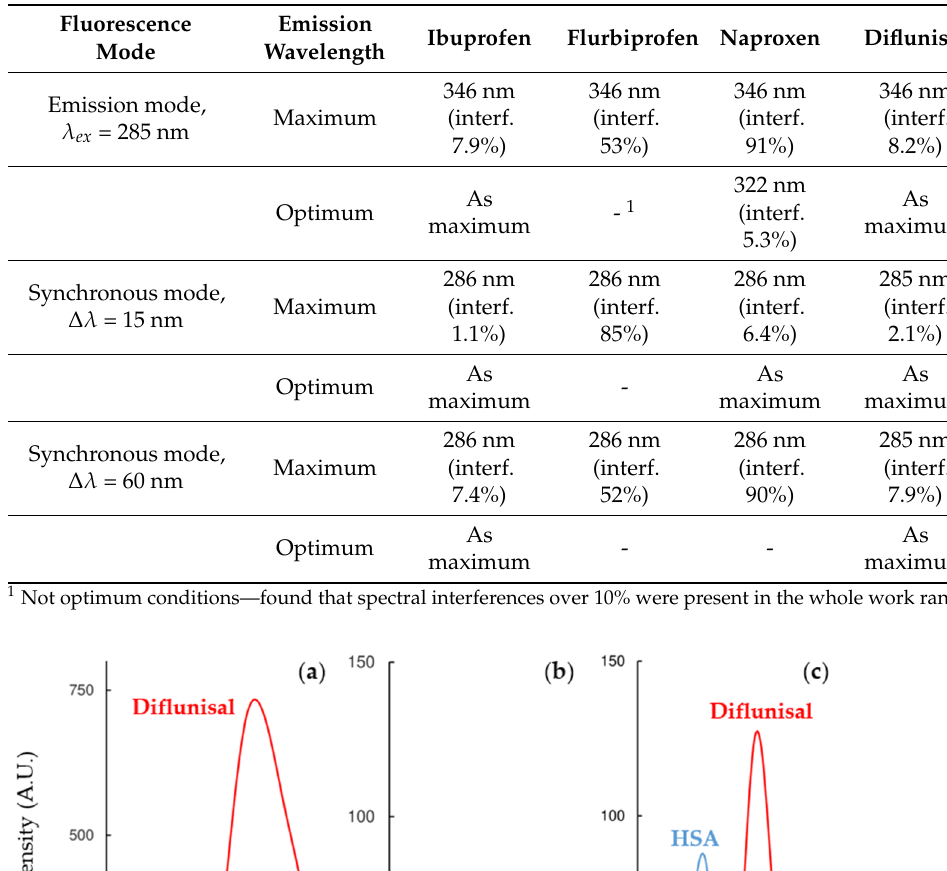
Table 1. Percent spectral interferences produced by the different non-steroidal anti-inflammatory drugs (NSAIDs) over the human serum albumin (HSA) spectrum at the wavelengths that provide the maximum fluorescence signal and at the optimal experimental conditions.